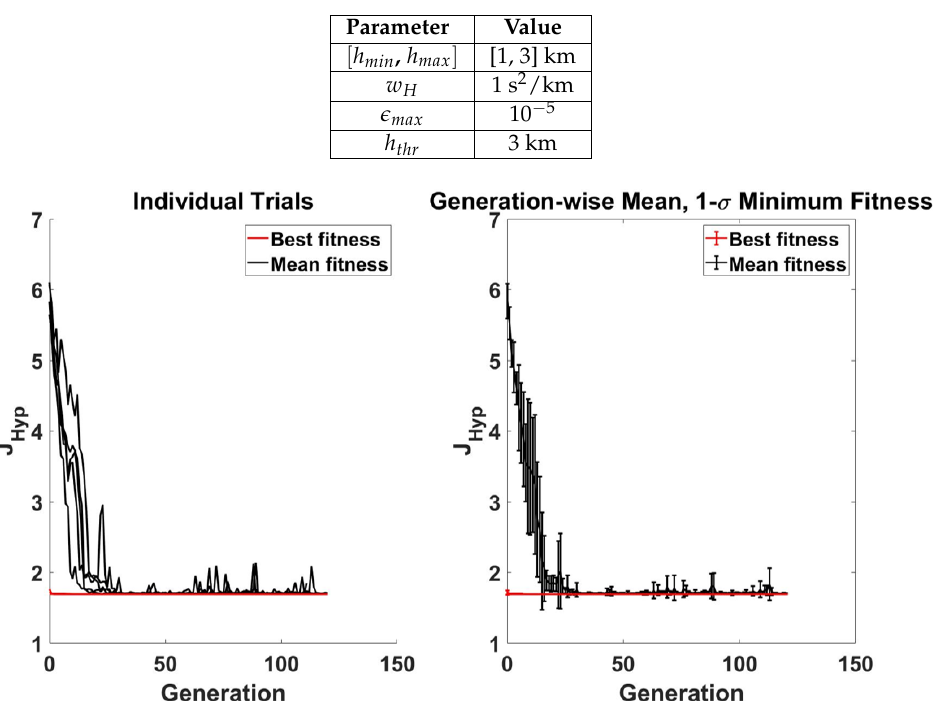
Table 9. Parameters and bounds supplied as inputs to the hyperbolic mission concept design.